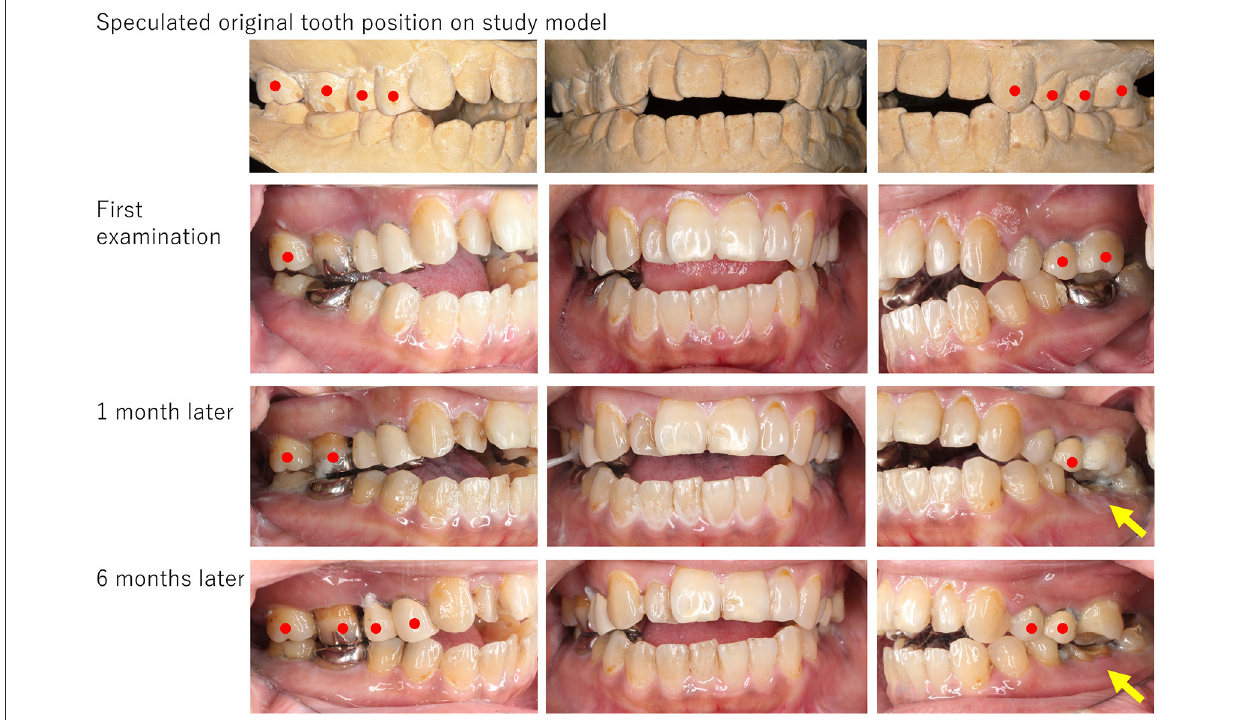
FIGURE3 The picture of a patient (Case No. 8). Open bite was obvious, but occlusal contact was observed on the right second molar, left second premolar, and left molars. Frontal teeth showed open bite even on the study model; however, the left canine and both sides of the premolars and molars engaged tightly. After 6 months of follow-up, drug-induced open bite improved gradually close to the occlusion observed in the study model. Although the dental crown on the lower left first molar had been removed for the root canal treatment (yellow arrows), any other dental procedures including occlusal adjustment had not been presented. Red circles indicate teeth that have occlusal